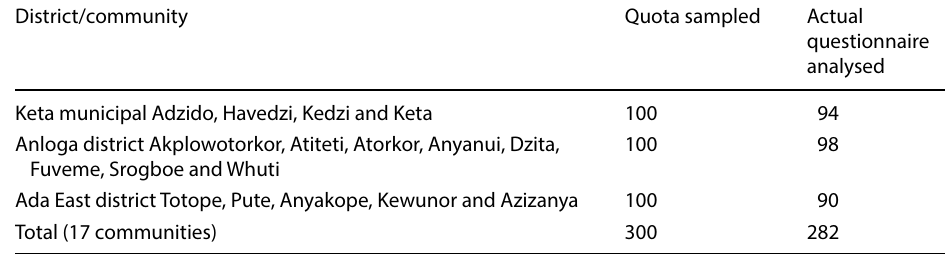
Table 1 Sample Size of District/community Quota sampled Actual Communities